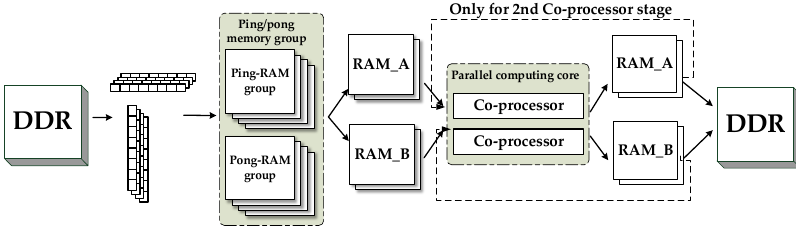
Figure 11. Unified flow chart of the parallel processing procedure.